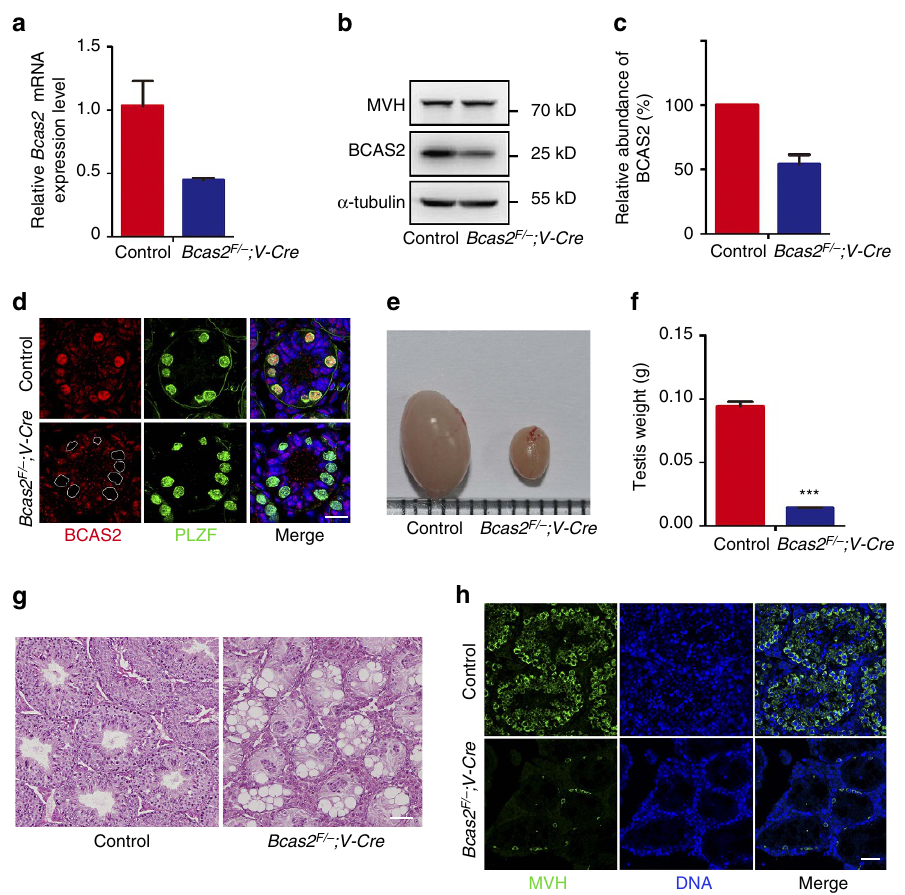
Figure 2 | BCAS2 is required for germ cell development and male fertility. ( a ) Real-time RT-PCR analysis of Bcas2 mRNA levels in control and Bcas2 F/ (cid:2) ;Vasa-Cre ( Bcas2 F/ (cid:2) ;V-cre ) testes of P8 mice with Hprt as the internal control ( n ¼ 3). Error bars represent s.e.m. ( b ) Western blotting analysis of BCAS2 protein in control and Bcas2 F/ (cid:2) ; Vasa-Cre testes of P8 mice. MVH and a -tubulin was used as a germ cell marker and loading control, respectively. ( c ) Relative abundances of BCAS2 in the control and Bcas2 F/ (cid:2) ;Vasa-Cre testes of P8 mice were determined by Western blotting analyses from 4 independent experiments. Error bars represent s.e.m. ( d ) IF staining of BCAS2 in the control and Bcas2 F/ (cid:2) ;Vasa-Cre testes of P8 mice. White circles denote the BCAS2 null spermatogonia. PLZF was co-stained to indicate the location of spermatogonia. The DNA was stained with Hoechst 33,342. Scale bar, 20 m m. ( e ) Morphological analysis of adult testes showed that the Bcas2 F/ (cid:2) ;Vasa-Cre testes were smaller than the control. ( f ) Testes weight of adult control and Bcas2 F/ (cid:2) ;Vasa-Cre mice (*** P o 0.001, n ¼ 5). Error bars represent s.e.m. ( g ) Hematoxylin and eosin (H&E) staining of adult testes in control and Bcas2 F/ (cid:2) ;Vasa-Cre mice. Spermatocytes and spermatids were almost absent in the seminiferous tubules of the Bcas2 F/ (cid:2) ;Vasa-Cre mice. Scale bar, 100 m m. ( h ) IF staining of MVH (a germ cell marker) in adult testes in control and Bcas2 F/ (cid:2) ;Vasa-Cre mice. Compared with the control, only a few MVH positive cells in the basement membrane were observed in Bcas2 F/ (cid:2) ;Vasa-Cre testes. The DNA was stained with Hoechst 33342. Scale bar, 50 m m. expressed in the undifferentiated spermatogonia 37 . In the Table 1 | The fertility of Bcas2 F/ (cid:2) ;Vasa-Cre males. literature, spermatogonia expressing only MVH but not PLZF (MVH þ PLZF (cid:2) ) around the basement membrane of Genotype seminiferous tubules in the testis are regarded as differentiating spermatogonia 38 . Thus, we simultaneously determined the expression of PLZF and MVH in the cells around the basement membrane of seminiferous tubules in P10 testes of control and Bcas2 F/ (cid:2) ;Vasa-Cre mice. Compared with the control, the number of all stages of germ cells (MVH þ ) around the basement membrane and differentiating spermatogonia (MVH þ PLZF (cid:2) ) was not significantly different in Bcas2 F/ (cid:2) ;Vasa-Cre testes (Fig. 4c,d), suggesting that the proliferation of spermatogonia was (Supplementary Fig. 4a,b). Taken together, these data normal in Bcas2 F/ (cid:2) ;Vasa-Cre testes. To analyse the apoptosis of suggest that the spermatogonia are almost unaffected in spermatogonia, we performed double staining of PLZF and cleaved Bcas2 F/ (cid:2) ;Vasa-Cre mice. caspase 3 (CAP3) in Bcas2 F/ (cid:2) ;Vasa-Cre testes. Compared with the control, the number of CAP3 þ PLZF þ spermatogonia was not significantly higher in Bcas2 F/ (cid:2) ; Vasa-Cre testes (Fig. 4e,f), BCAS2 modulates pre-mRNA splicing in spermatogenesis . To implying that the spermatogonia did not undergo apoptosis. investigate the molecular consequences of BCAS2 depletion in Antibodies to the MVH protein label all stages of germ cells, we isolated mRNA from control and Bcas2 F/ (cid:2) ; spermatogonia and spermatocytes 36 , and PLZF is specifically Vasa-Cre testes at P9 and performed RNA sequencing. A total of NATURE COMMUNICATIONS|8:14182|DOI: